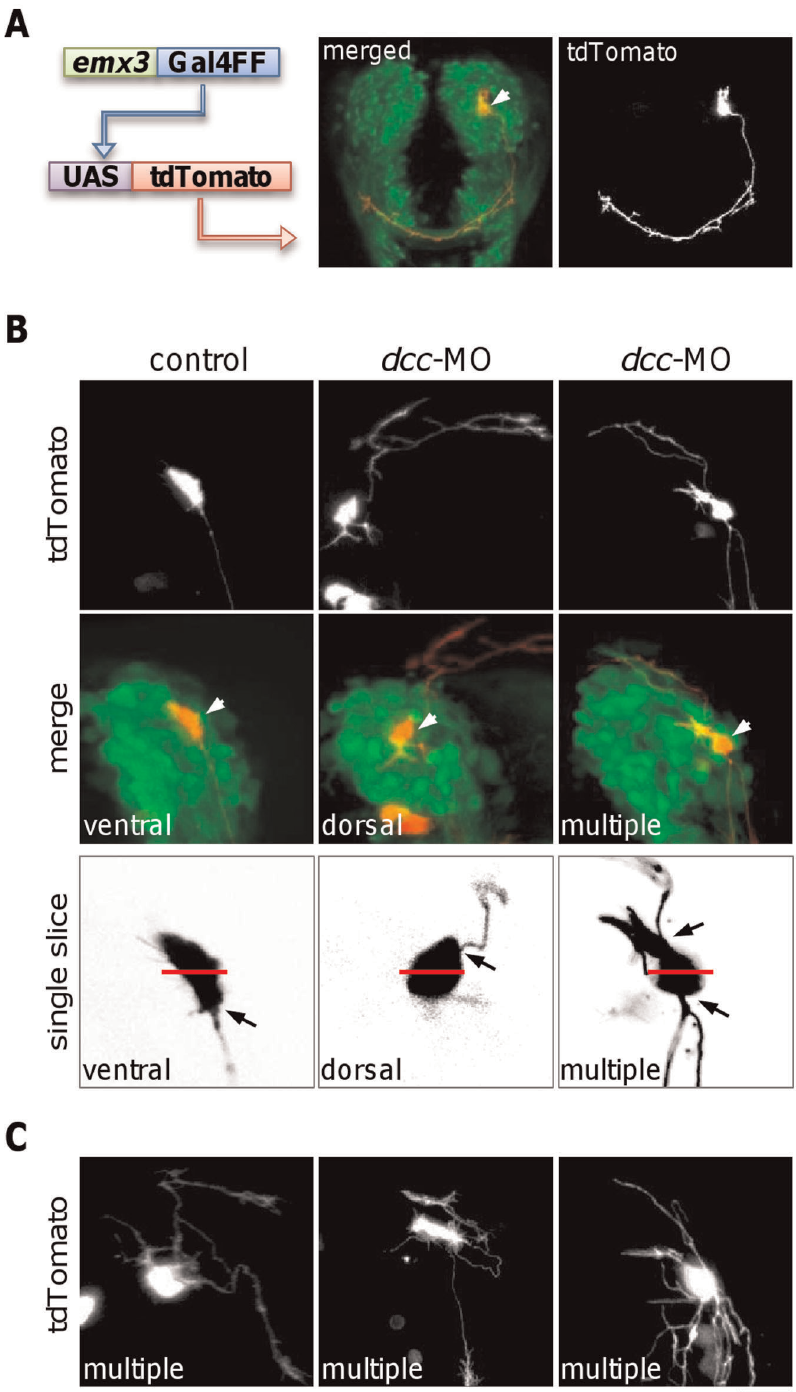
Figure 4. Inhibition of Dcc function causes ADt axons to project dorsally or to form multiple processes. ( A ) Labeling of individual ADt neurons by mosaic expression of fluorescent protein tdTomato. Image of a live 36 hpf Tg(lhx5BAC:Kaede) animal that was injected with emx3:Gal4FF and UAS:tdTomato plasmids is shown. The tdTomato labeled neuron projected an axon into the AC. Merge panel shows the position of the tdTomato labeled soma (marked by an arrowhead). Scale bar=50 m m. ( B ) Injection of dcc morpholino causes ADt neurons to project axons dorsally or to form multiple processes. Labeled ADt neurons are marked by arrowheads in the merged panels. Left panels show an ADt neuron with a normal ventrally projecting axon in a control animal. Middle panels show an ADt neuron with an aberrant dorsally projecting axon in a dcc -MO injected animal. Right panels show an ADt neuron with both ventrally and dorsally projecting processes. Black arrow in the single slice images indicates the origin of the axon on the surface of the cell body. Red bar indicates the middle of the dorsal and the ventral side of the labeled neuron cell body. Scale bar equals to 20 m m in the projected images or 10 m m in the single slice images. ( C ) Additional examples of ADt neurons with multiple aberrant axons in dcc - MO injected animals. Scale bar=15 m m.